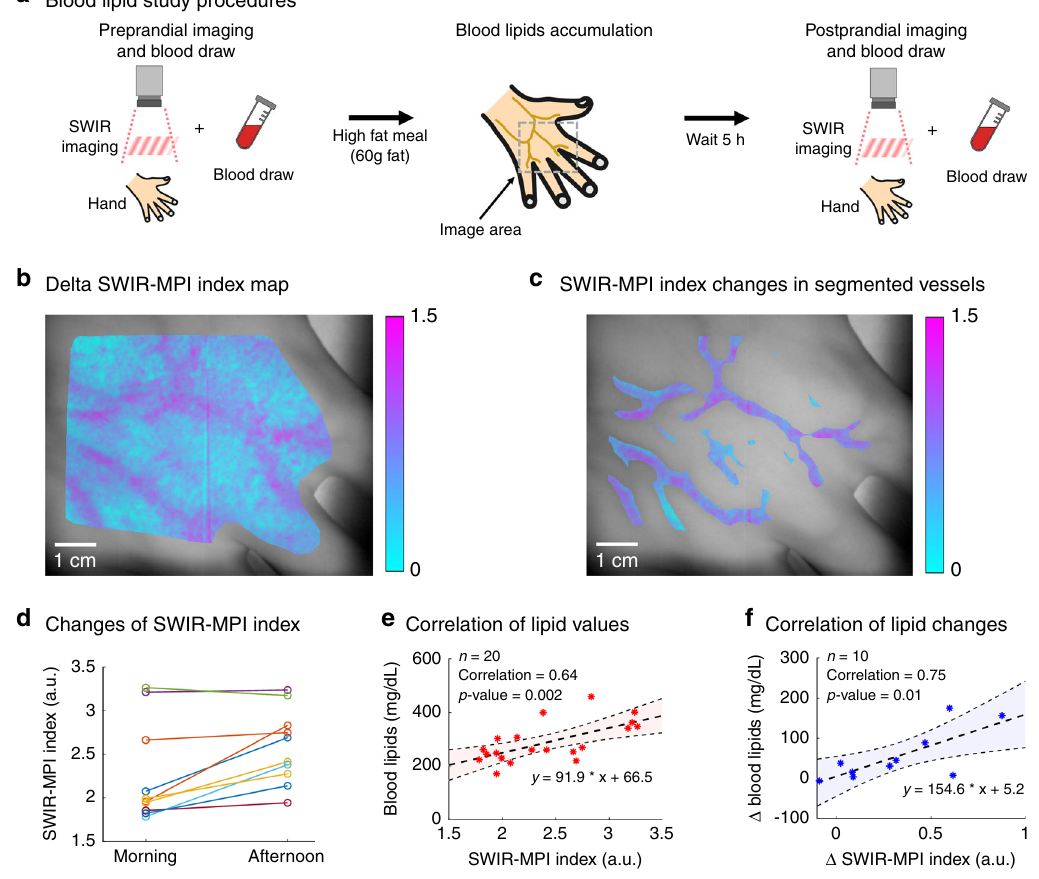
Fig. 5 Pre- and post-prandial blood lipid measurement in human subjects. a Outline of study protocol. Normal subjects were measured with SWIR-MPI in the morning after fasting for 10 h overnight. A blood draw was taken immediately after imaging. Subjects then consumed a high-fat meal (containing 60 grams of fat). A second SWIR-MPI measurement and blood draw were conducted 5 hours later. Blood lipids (triglycerides and cholesterol) were determined from blood draws and used as the gold standard. b A representative map of change in SWIR-MPI index on the back of a subject ’ s hand. Major blood vessels (subcutaneous veins) are clearly visible. c Change in SWIR-MPI index in automatically segmented blood vessels. d Changes in SWIR-MPI index for ten individual subjects. Nine out of the ten subjects exhibited an increase in SWIR-MPI index over the 5-hour period after eating the high-fat meal, consistent with blood draw results (supplementary Table 8). e Correlation between SWIR-MPI index and absolute lipid values obtained from blood draws (Pearson correlation coef fi cient: 0.64). The shaded area indicates 95% con fi dence bounds for the data fi t. f Correlation between changes in SWIR-MPI index and changes in absolute blood lipid values over the 5-hour period (Pearson correlation coef fi cient: 0.75). The shaded area indicates 95% con fi dence bounds for the data fi t. Source data are provided as a Source Data fi le. The picture of the hand in a was generated using Google